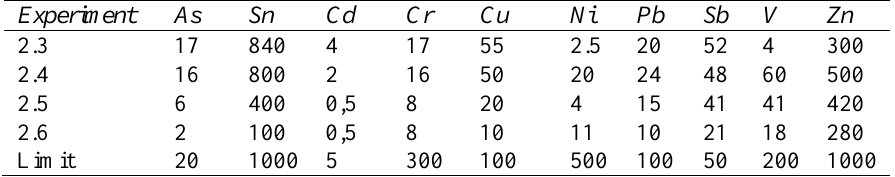
Table 5. Concentrations of leachate in Extraction medium 2 after TCLP test (mg L -1